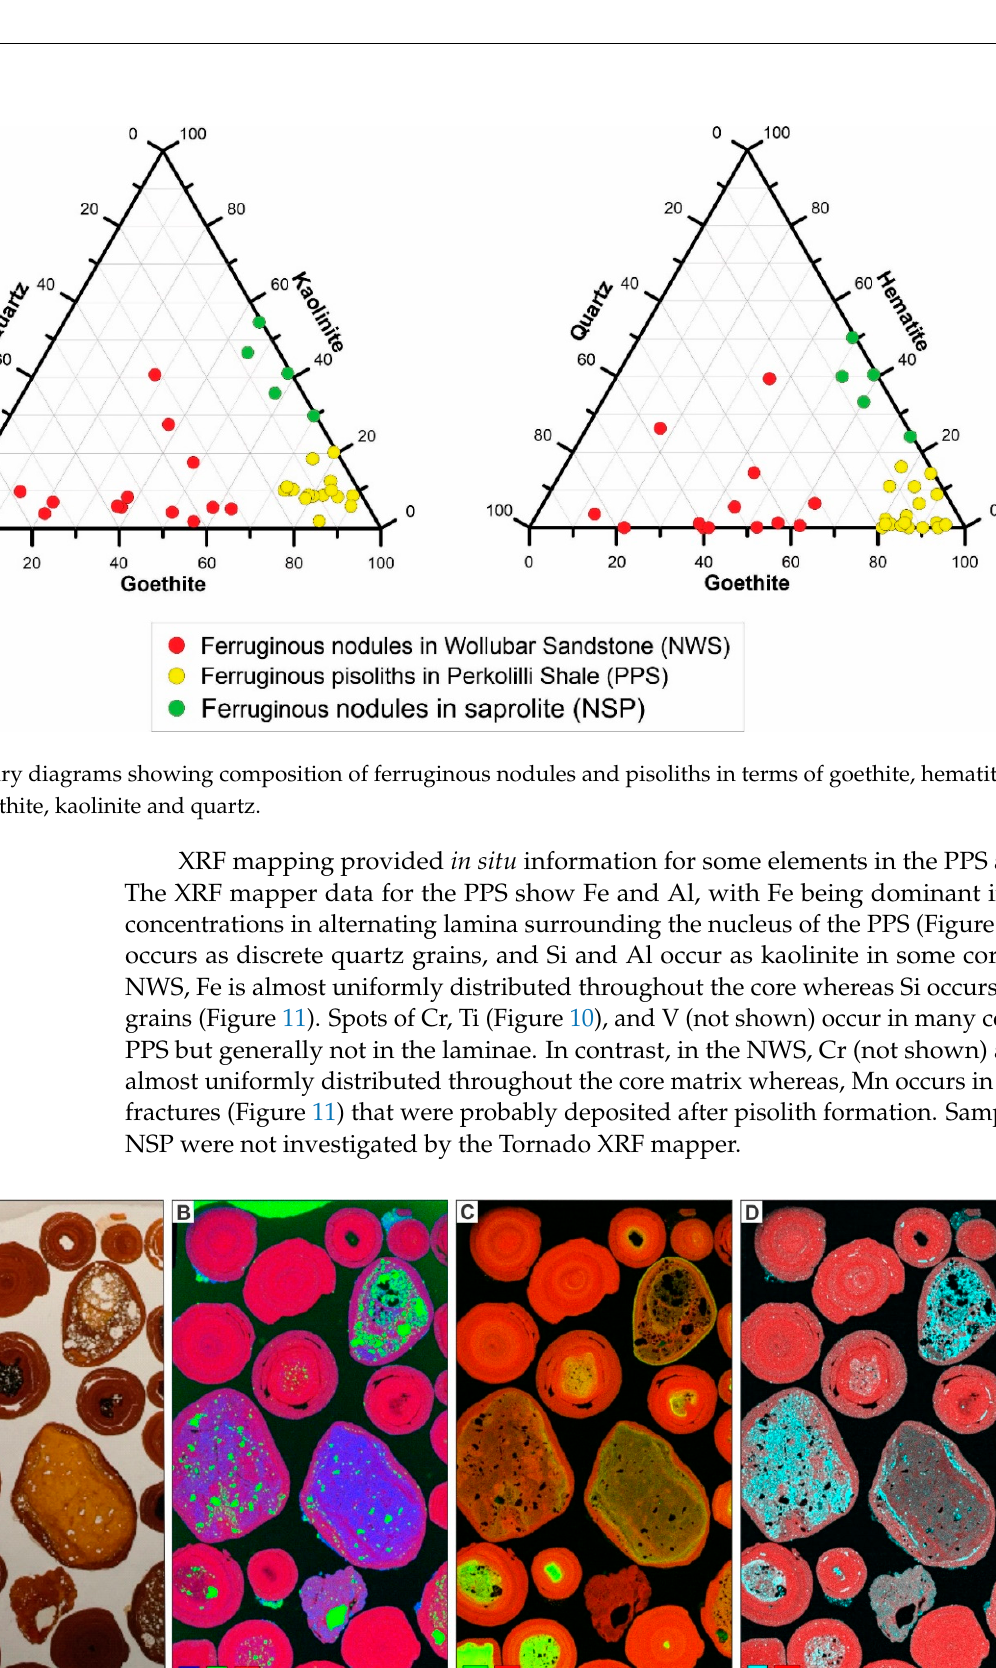
Figure 10. ( A ) Photograph of a polished thin section of ferruginous pisoliths formed in the Perkolilli Shale, PPS. ( B – D ) Bruker XRF elemental maps ( B ) RGB image of Al, Si and Fe in pisoliths, ( C ) Cr and Fe and ( D ) Ti and Fe.